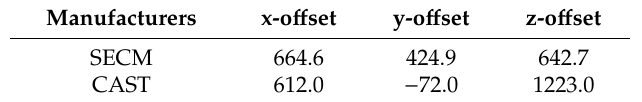
Table 7. The laser retroreflector arrays (LRA) o ff sets of the BeiDou-3 satellites. The unit is mm. Manufacturers x-o ff set